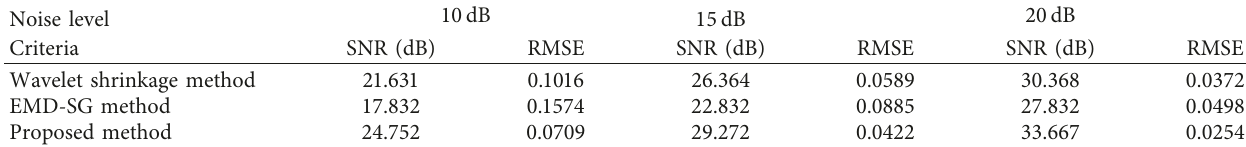
Table 2: De-noised results in SNR and RMSE of non-linear signal corrupted by different noise levels. Noise level